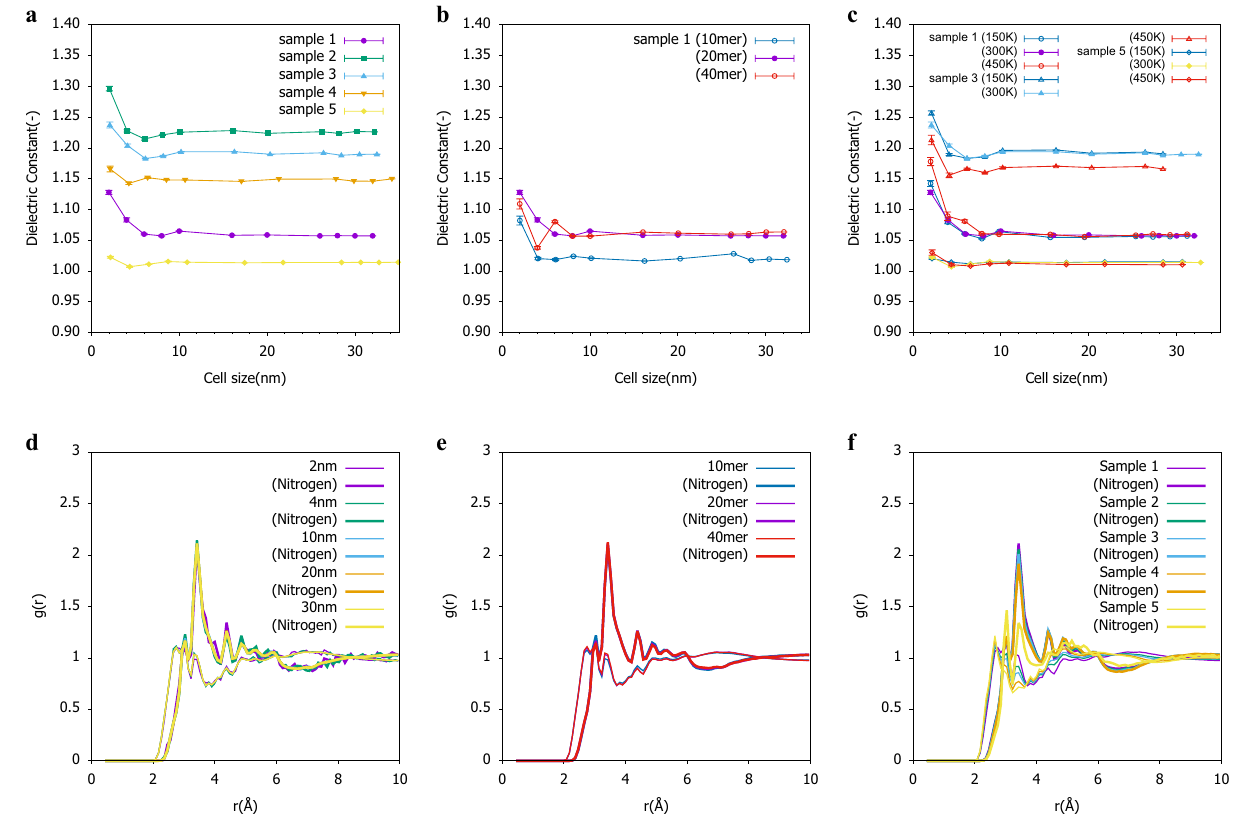
Figure 2. The change in dielectric constant (DC) and the radial distribution function (RDF) for the simulation cell size. Error bars in DC represent ± 3 σ . (a) DC effect of monomer ratio. (b) DC effect of polymer chain length in sample 1. (c) DC effect of temperature in samples 1,2 and 5. (d) RDF effect of simulation cell size in sample 1. The thin line is the total RDF, and the thick line is the total RDF for Nitrogen in the side chain. Same as below. (e) RDF effect of polymer chain length in sample 1 and 20nm cell size. (f) RDF effect of monomer ratio in sample 1 and 20nm cell